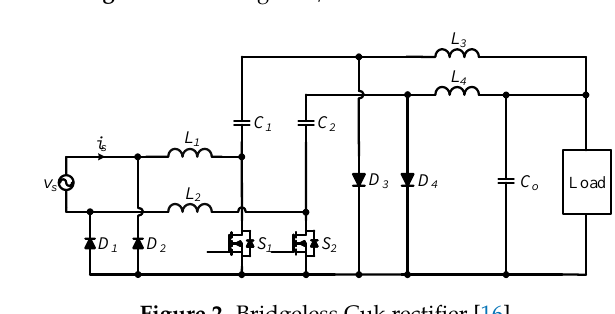
Figure 2. Bridgeless Cuk rectifier [16].